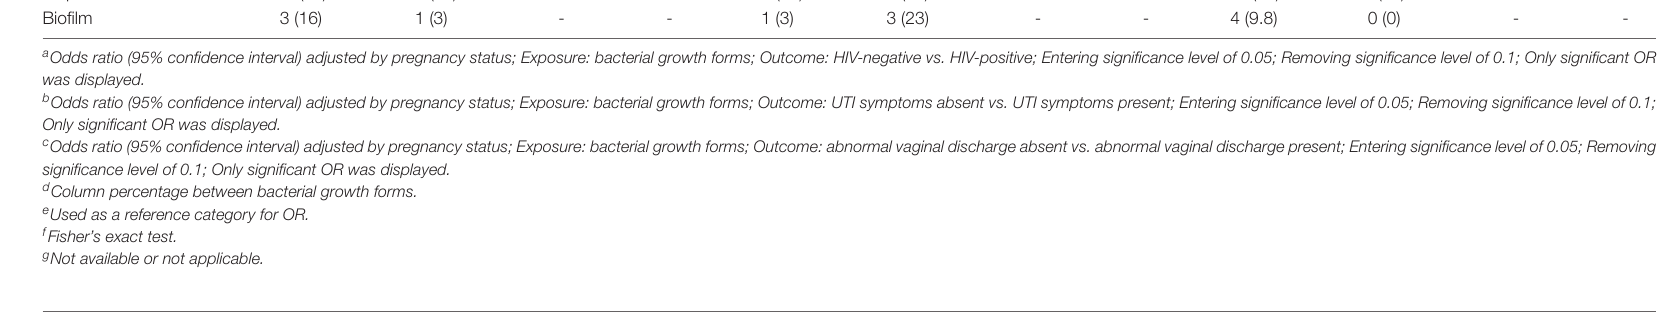
TABLE 6 | Association of growth forms of Gardnerella spp. and Lactobacillus species in relation to clinical characteristics in BV-positive women (Ison-Hay criteria a ). Bacterial growth form